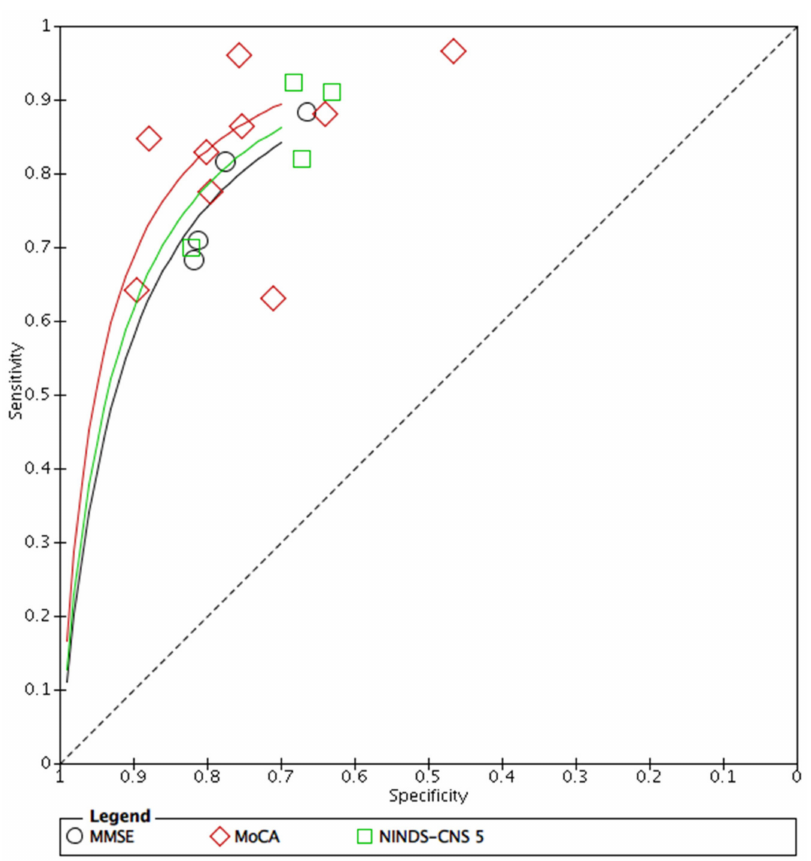
Figure 4. Exploratory SROC curve for diagnostic accuracy of the MMSE, MoCA, and NINDS-CNS 5; MMSE: Mini-Mental State Examination; MoCA: Montreal Cognitive Assessment; NINDS-CNS 5: The National Institute of Neurological Disorders and Stroke–Canadian Stroke Network 5-Minute Protocol; SROC: summary receiving operating